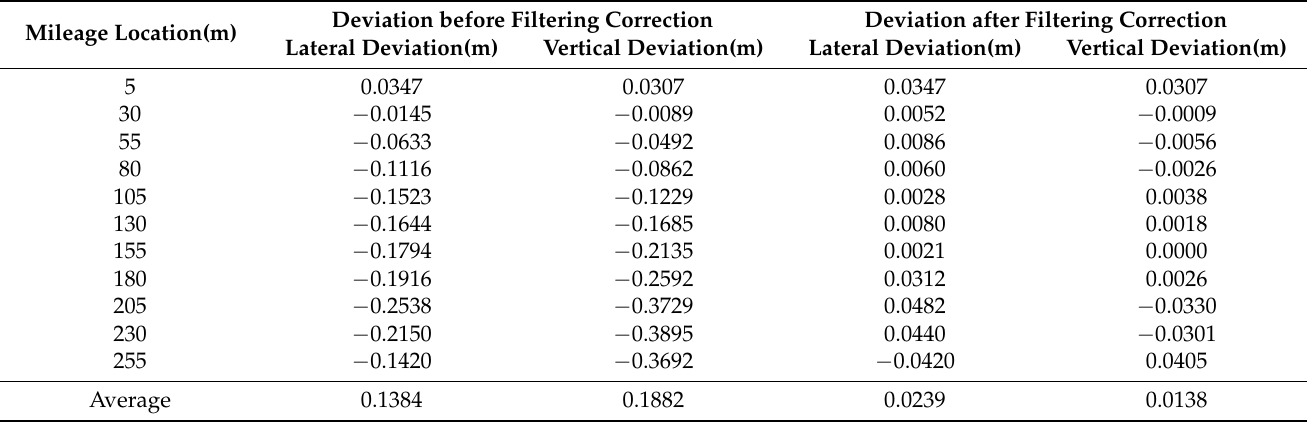
integrated navigation.